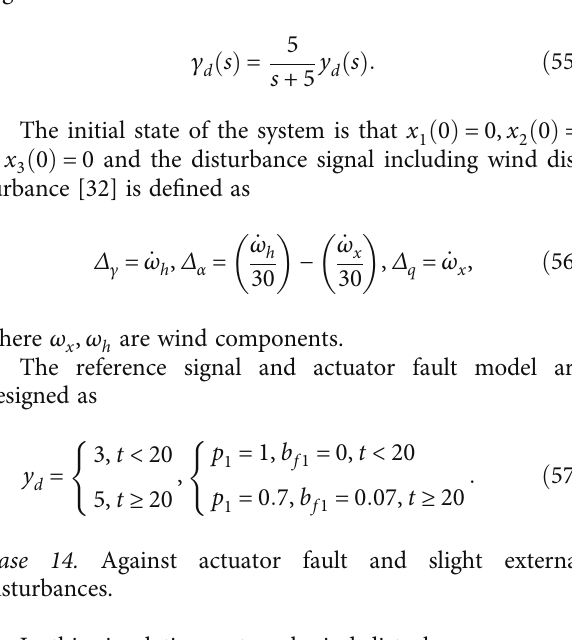
1 and trajectories of